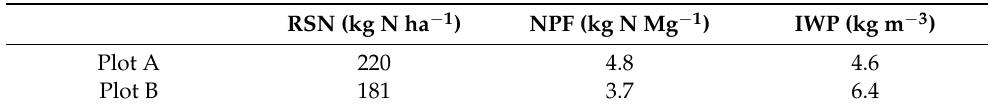
Table 6. Mean values of Residual Soil Nitrogen (RSN), Nitrogen Productivity Factor (NPF), and Irrigation Water Productivity (IWP) for plots A and B. RSN (kg N ha − 1 ) NPF (kg N Mg − 1 )